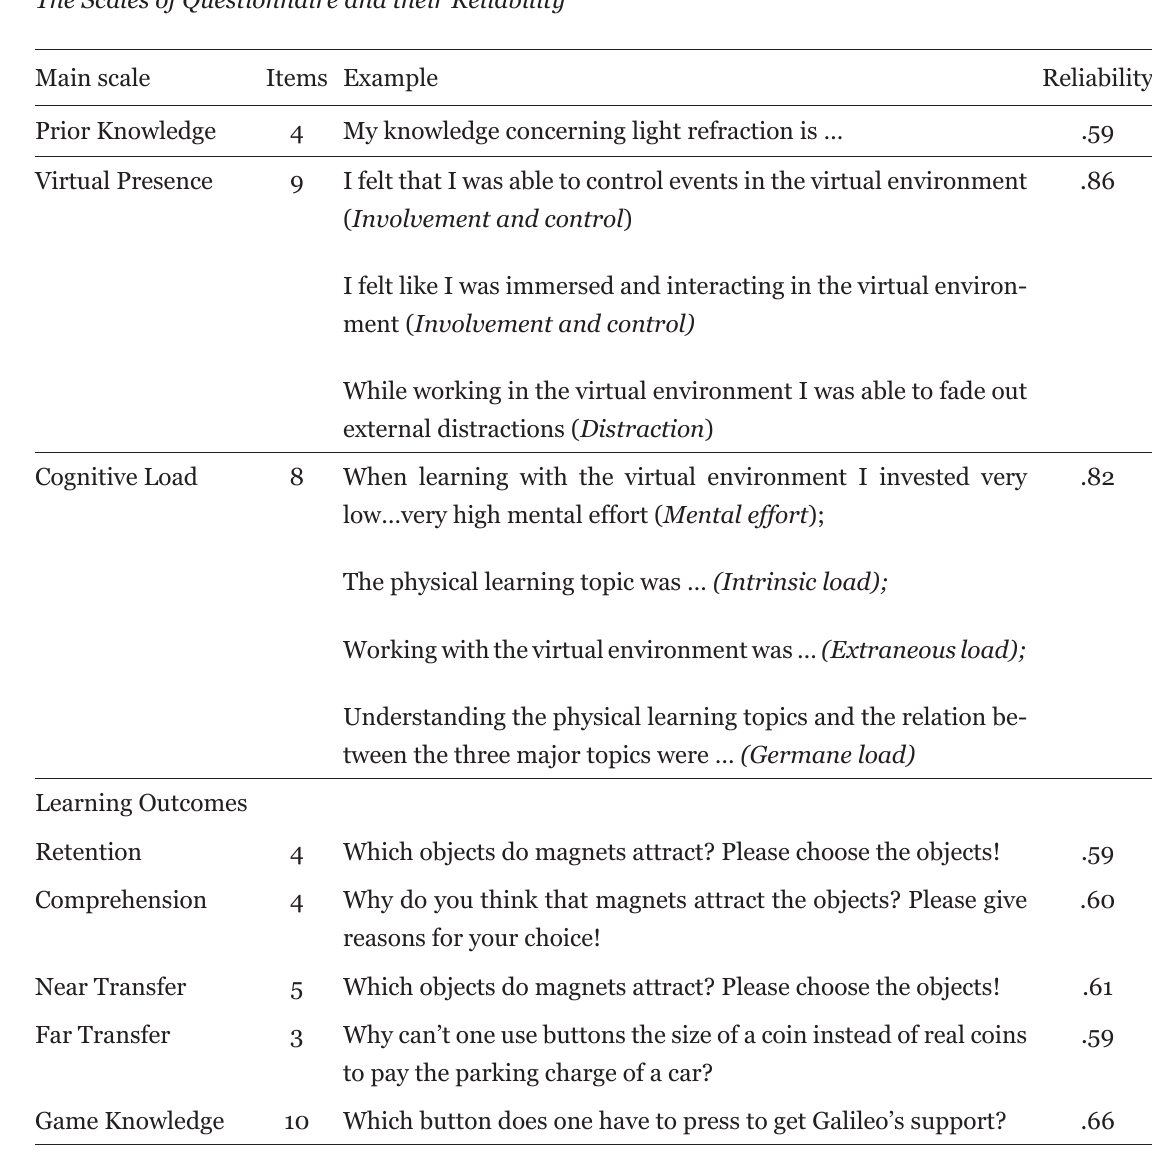
by an example of an item, and the reliability coefficients of all scales.